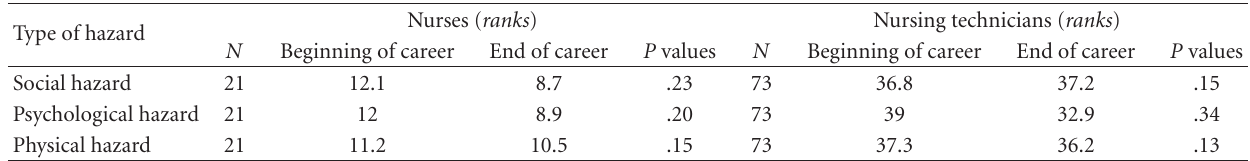
Table 5: Physical, psychological, and social hazards among nurses and nursing technicians at the beginning and end of their careers, according to the Kruskal Wallis test, Bras´ılia,